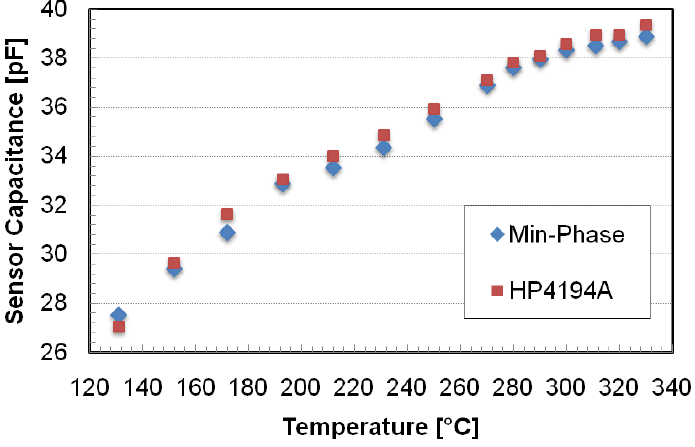
Figure 8. Sensor capacitance directly measured by HP4194A and the data obtained by the telemetric